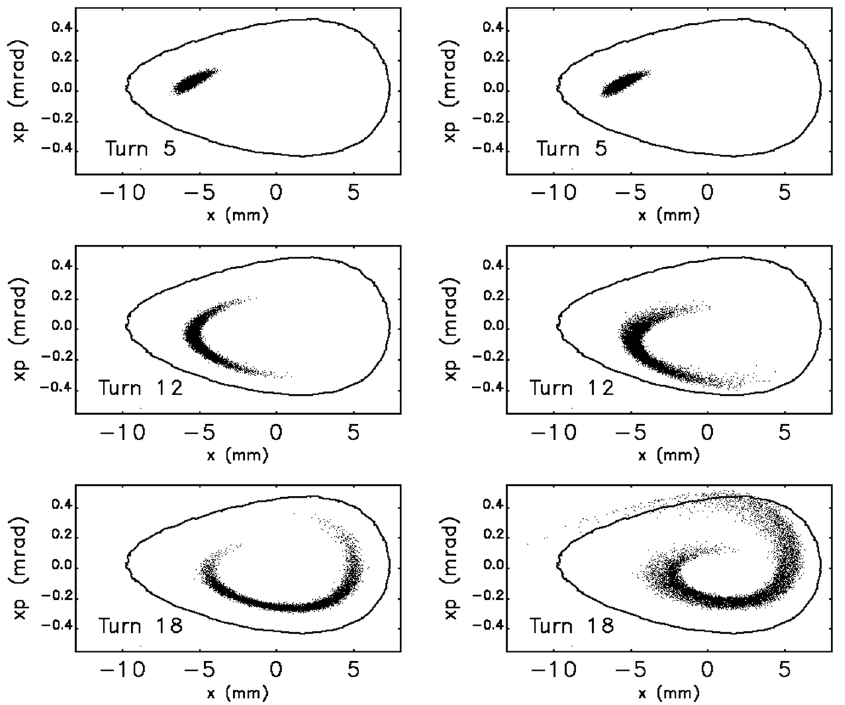
IPAC2015-TUPJE077.FIG. 10. Details of the horizontal phase space evolution of the 0.9 mA bunch (left column) and 4.1 mA bunch (right column). Solid line shows the separatrix of the